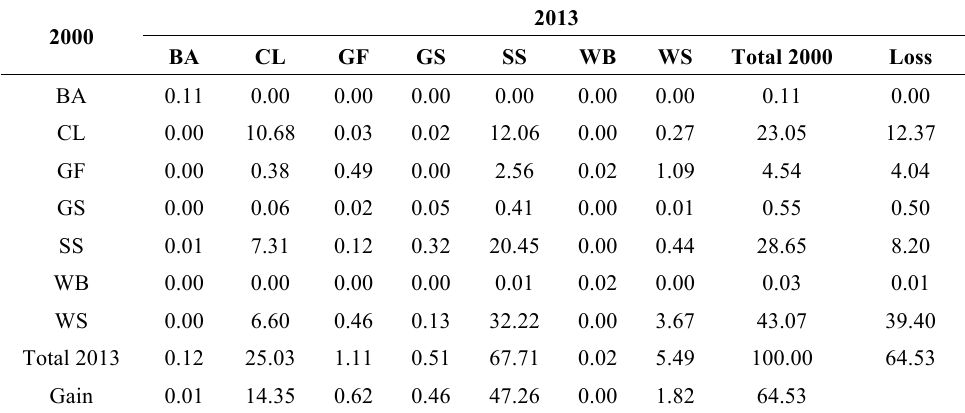
), loss-to-persistence ( L p